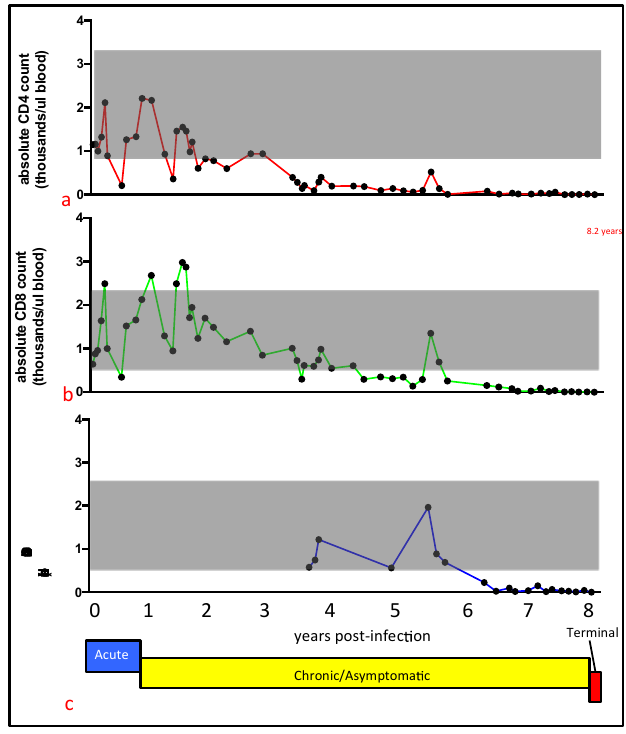
Figure 2. The absolute number of peripheral CD4, CD8, and CD21 cells progressively declined over the course of the infection. ( a ) CD4, ( b ) CD8, and ( c ) CD21 cells are graphed in thousands of cells/microliter blood vs. time PI (years). The grey shaded regions represent the mean numbers of leukocytes ± standard deviation for the two uninfected control cats during the eight-year study period. The clinical trajectory of FIV for cat 165 is depicted below the x-axis for Figure 2c, acute stage (blue), asymptomatic stage (yellow) and terminal stage